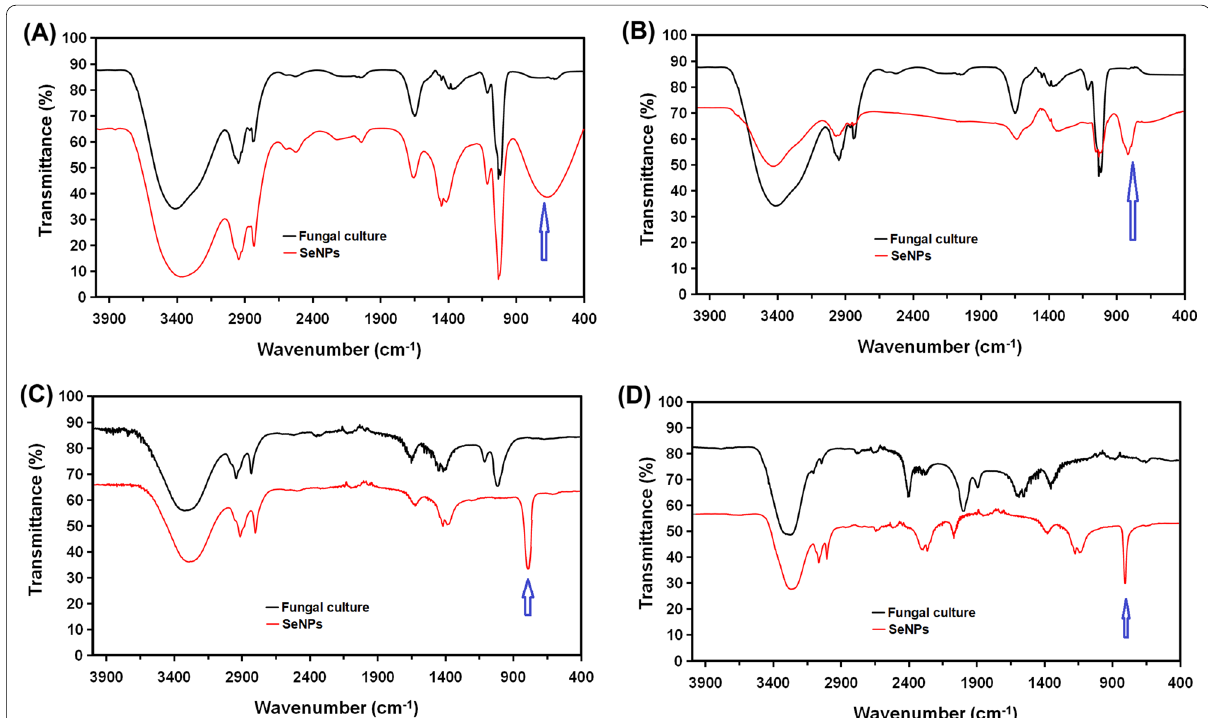
Fig. 5 FTIR spectra of the fungal culture (Black line) and the synthesized SeNPs (Red line). A FTIR spectrum of SeNPs synthesized by A. quadrilineatus , B FTIR spectrum of SeNPs synthesized by A. ochraceus , C FTIR spectrum of SeNPs synthesized by A. terreus , and D FTIR spectrum of SeNPs synthesized by F.